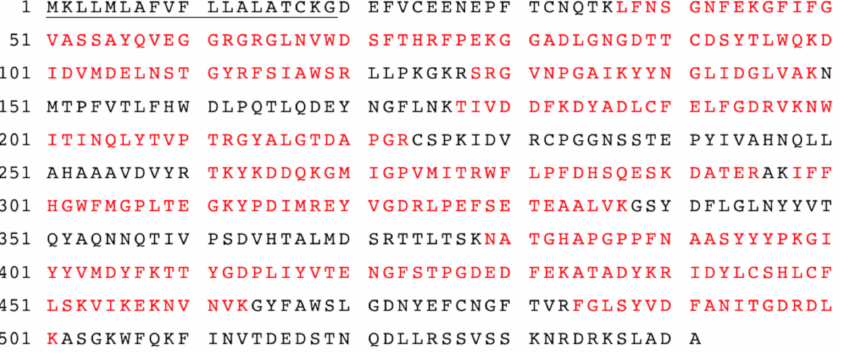
Figure 4. The amino acid sequences of At TGG1 myrosinase identified by LC-MS-MS analysis. The amino acid sequence coverage of myrosinase ( myr- ∆ 19) with identified peptides was 61%. Matched peptides shown in red. The underlined amino acids represent the native signal